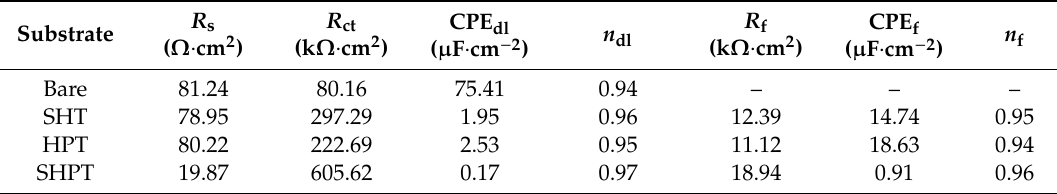
Table 3. EIS parameters of bare and treated TNZ